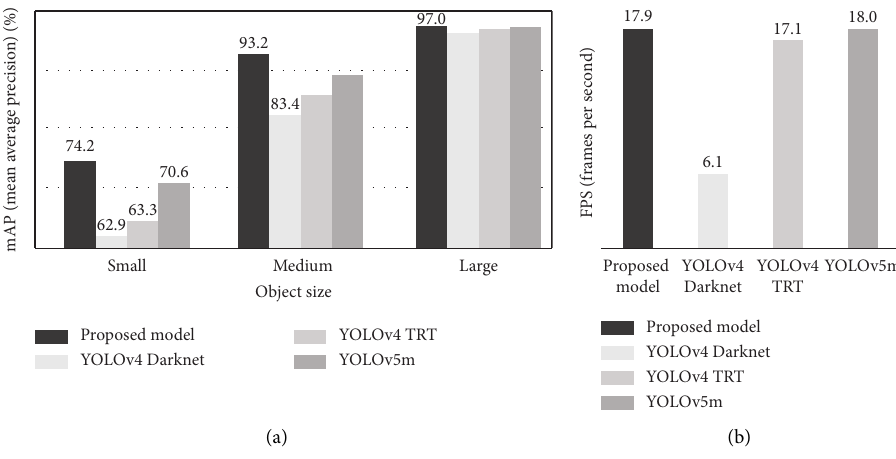
Figure 2: Object detecting performance comparison: (a) mean average precision (mAP) and (b) frames per second